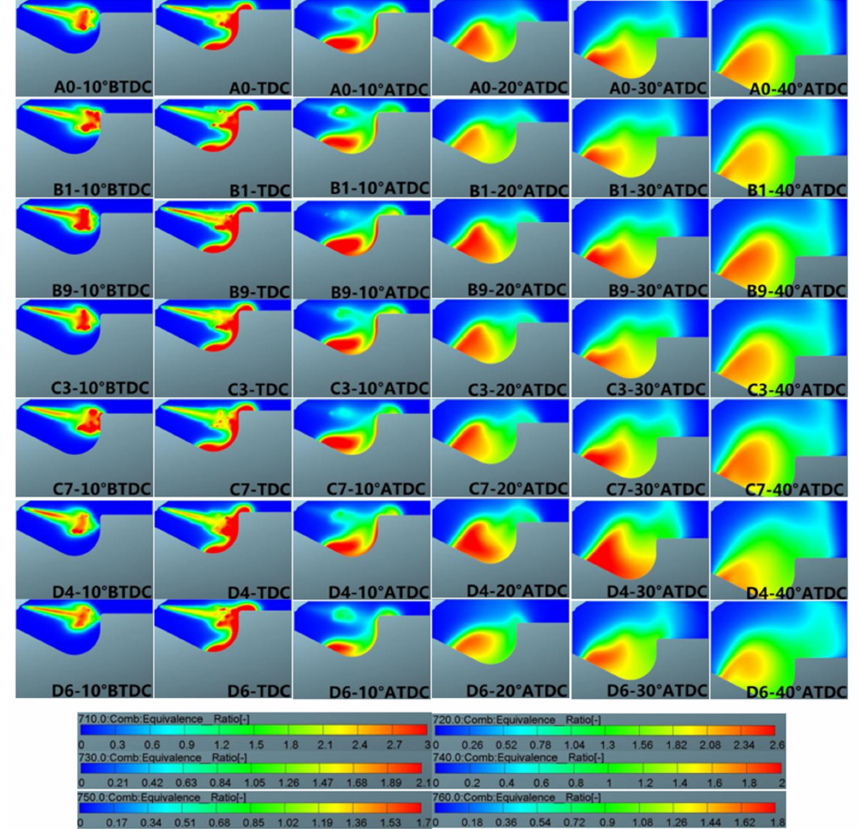
Figure 41. Distribution of equivalence ratio for pre-optimized